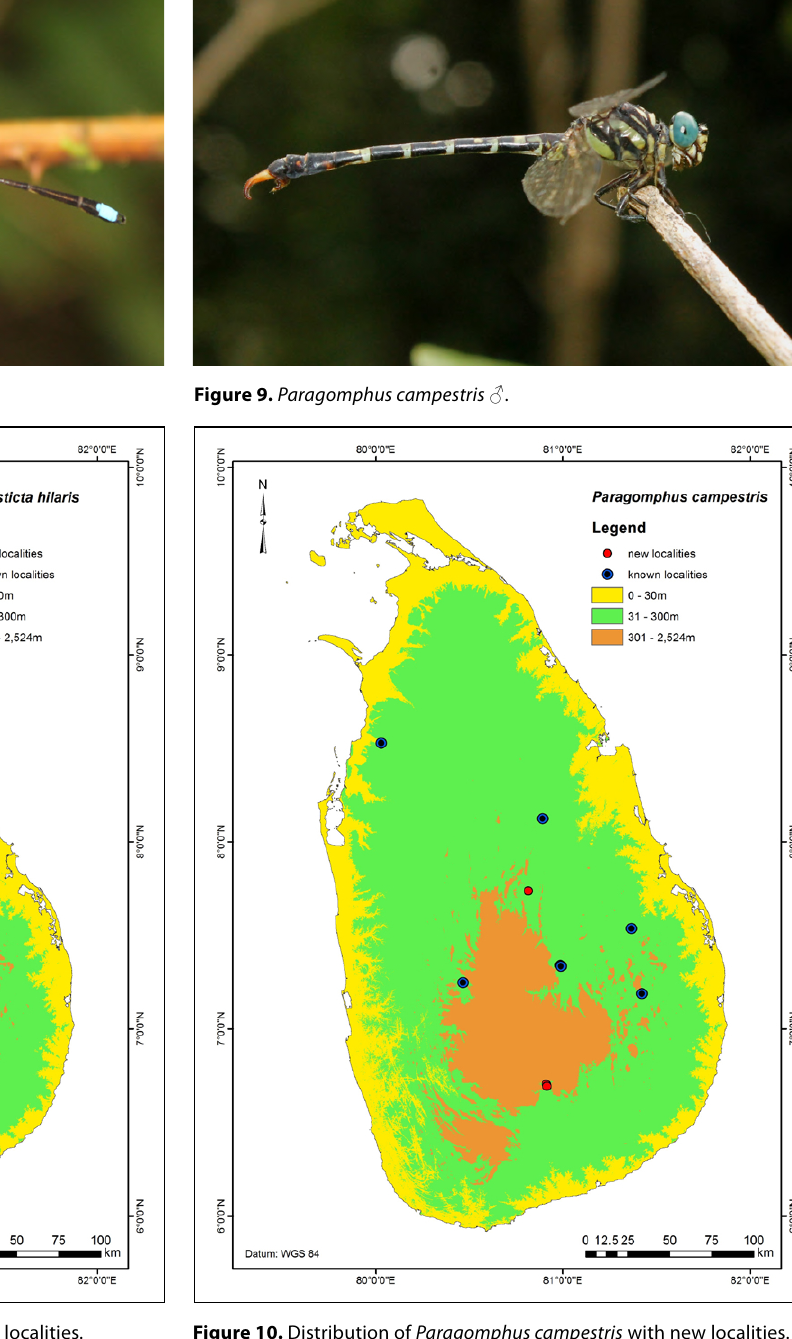
Figure 8. Distribution of Ceylonosticta hilaris with new localities. Figure 10. Distribution of Paragomphus campestris with new